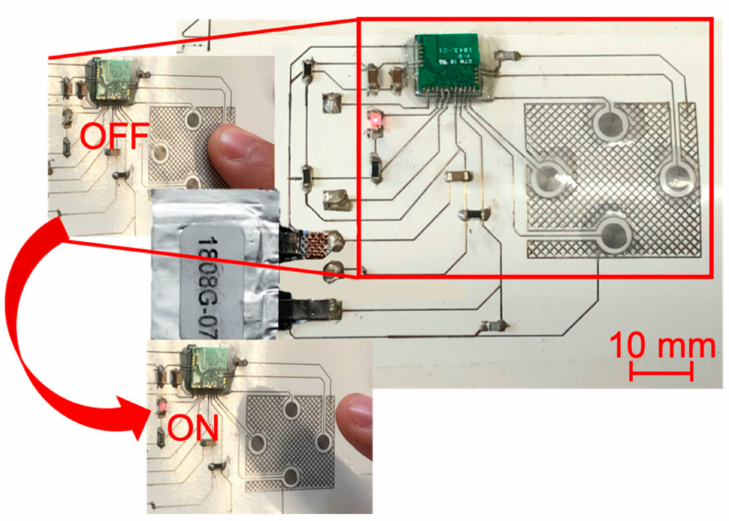
Figure 11. Optomec AJ300 with photopaper tube during printing step.